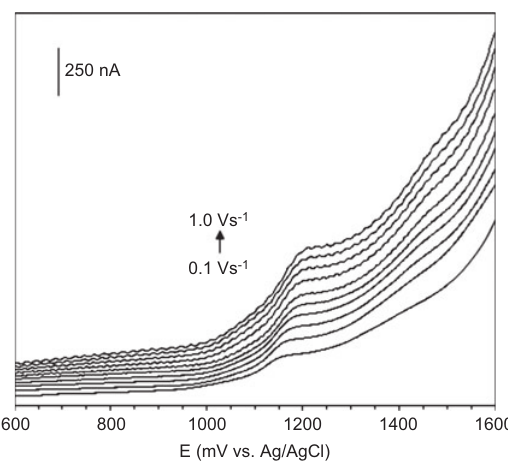
Figure 3 Linear sweep voltammograms for the oxidation of 10 µ g/ml carvedilol in acetonitrile containing 0.1 m TBAClO tion of scan